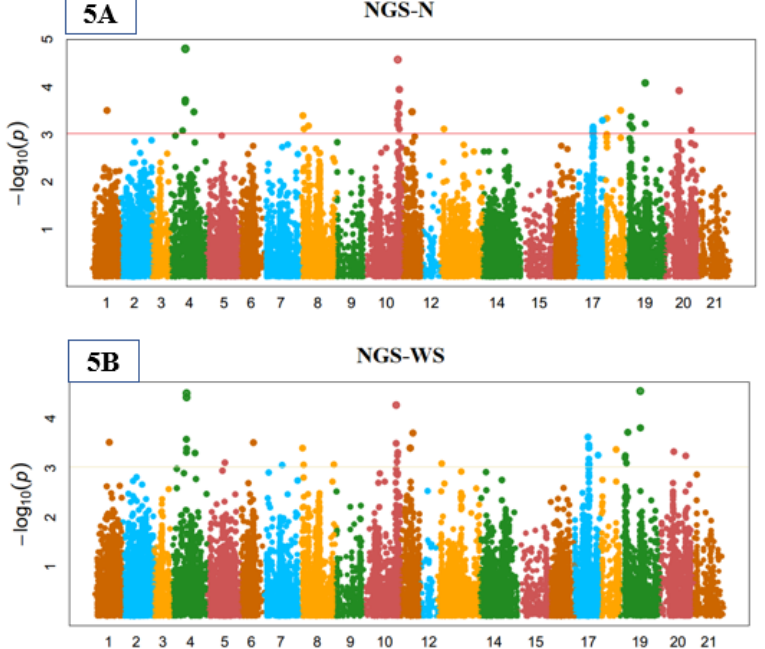
Figure 5. Manhattan plot of number of grain per spike (NGS) under normal (N) ( A ) and water short- age (WS) ( B ) conditions. Manhattan plots showing the location of significant SNPs and − log10( p ) associated with number of grain per spike in bread wheat under normal and water shortage condi- tions. The red horizontal line on Manhattan plot entitles the threshold level ( p < 0.0001) of significance for SNPs with this trait.